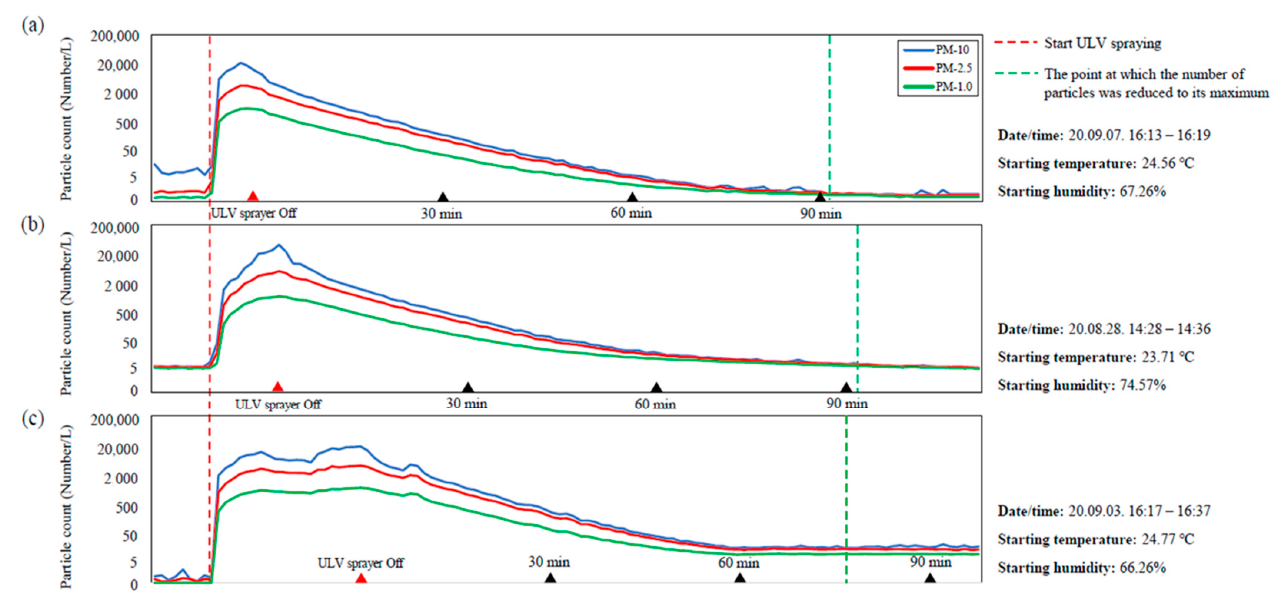
Figure 4. Variation of three different sizes of PM fractions after spraying with ULV sprayer: ( a ) variation of PM 10 , PM 2.5 , and PM 1.0 after dispensing using a ULV sprayer when the spray amount was 2 L in 230 m 3 , ( b ) variation of PM 10 , PM 2.5 , and PM 1.0 after dispensing using a ULV sprayer when the spray amount was 5 L in 230 m 3 , and ( c ) variation of PM 10 , PM 2.5 , and PM 1.0 after dispensing using a ULV sprayer when the spray amount was 8 L in 230 m 3 .